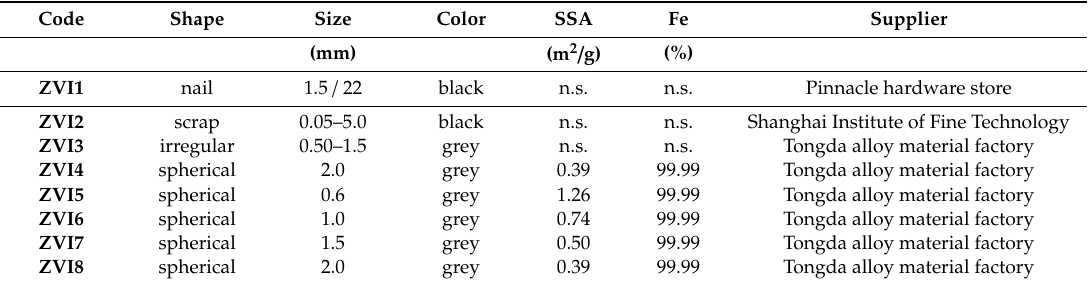
Table 2. Iron content, origin, name and main characteristics of tested Fe 0 materials as specified by the supplier. SSA stands for specific surface area. ‘n.s.’ stands for not